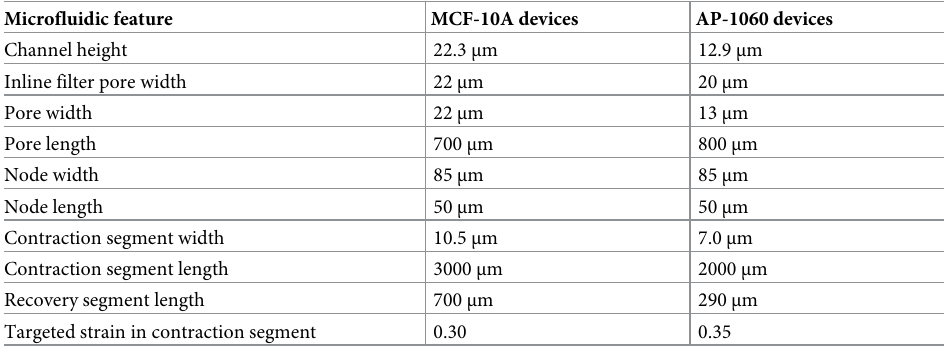
Table 1. Geometric dimensions of mechano-NPS